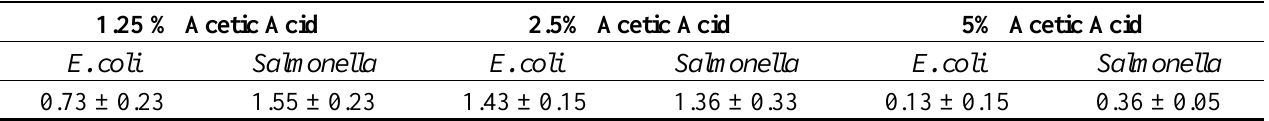
Table 1. Log reductions demonstrating acetic acid intervention at various concentrations and contact times against E. coli and Salmonella (pH 1.25% acetic acid = 2.8; 2.5% acetic acid = 2.6; 5% acetic acid = 2.4).